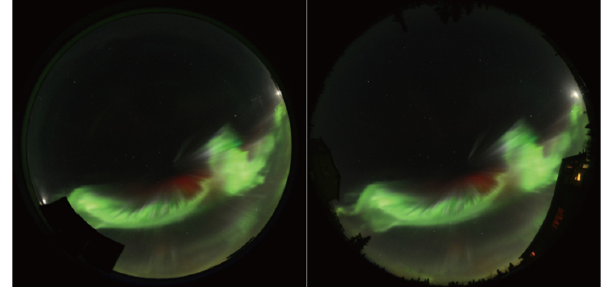
Fig. 3. Dome-master format (a) and corresponding geographic co- ordinate system (b) , where θ is the zenith angle, B is the azimuth angle from the north, and A is the longitude between the target and observer. See the text for